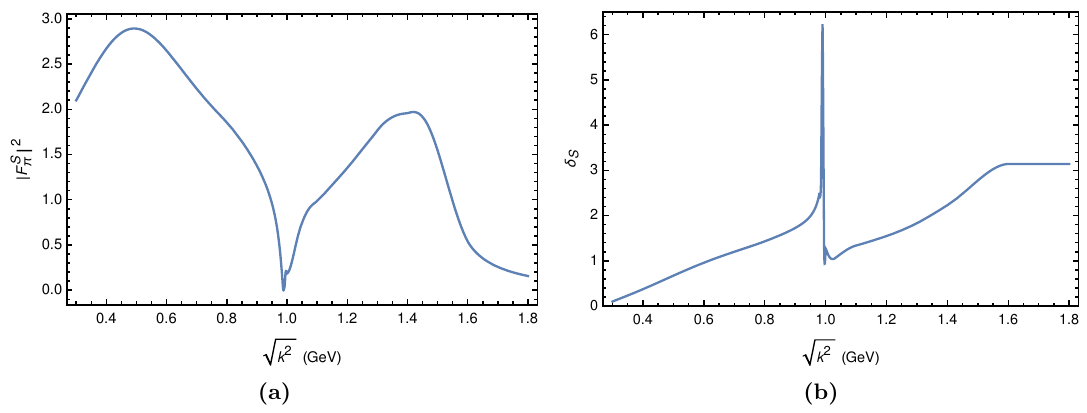
Figure 2. Pion scalar form factor F S